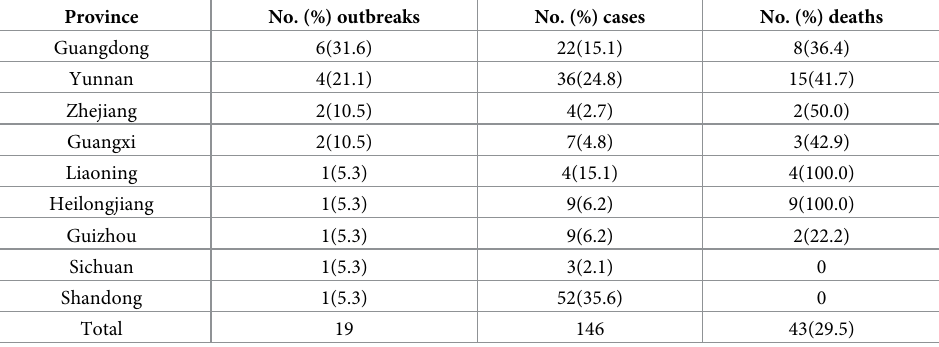
Table 3. Bongkrekic acid poisoning outbreaks, cases, and deaths by province in China, 2010–2020.